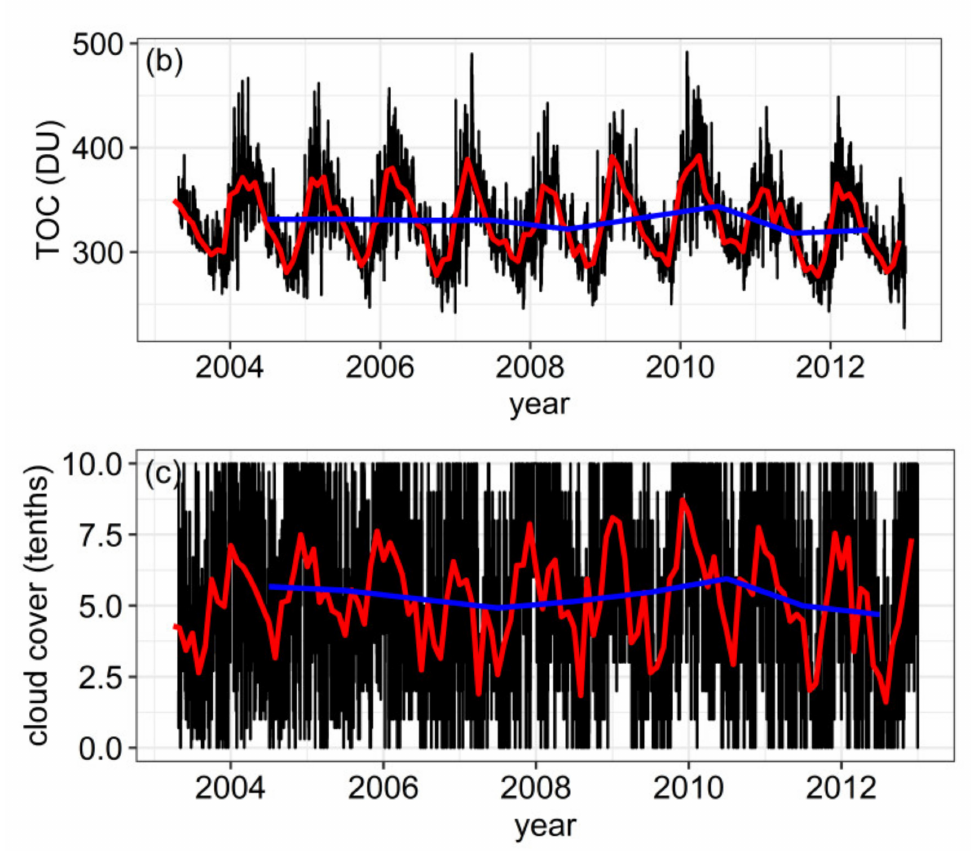
Figure 3. Evolution of the daily (black), monthly (red), and yearly average (blue) ( a ) H er (Jm − 2 ); ( b ) TOC (DU); and ( c ) cloud cover (tenths) in Novi Sad, Serbia, for the period April 2003– December